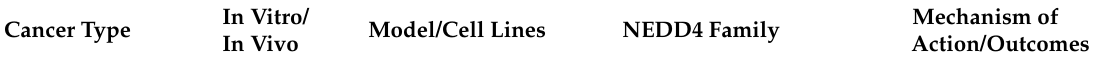
Table 2. Mechanistic role of NEDD4-like E3 ligase family in various